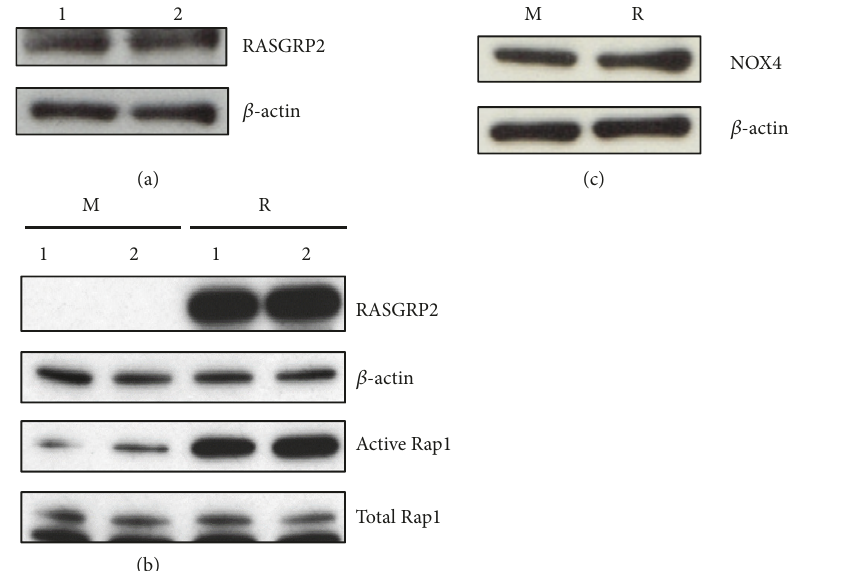
Figure 1: Effect of RASGRP2 overexpression on Rap1 activation and NOX4 expression. (a) Expression of endogenous RASGRP2 protein with overexposure using X-ray film. 1: HUVEC, 2: TERT HUVEC. (b) Activated Rap1 in TERT HUVEC was recovered using RalGDS-RBD Agarose Beads and validated by western blot. M: mock cells; R: TERT HUVEC R cells. 1 and 2: each of two single cell clones obtained by establishment. (c) Expression of NOX4 protein in TERT